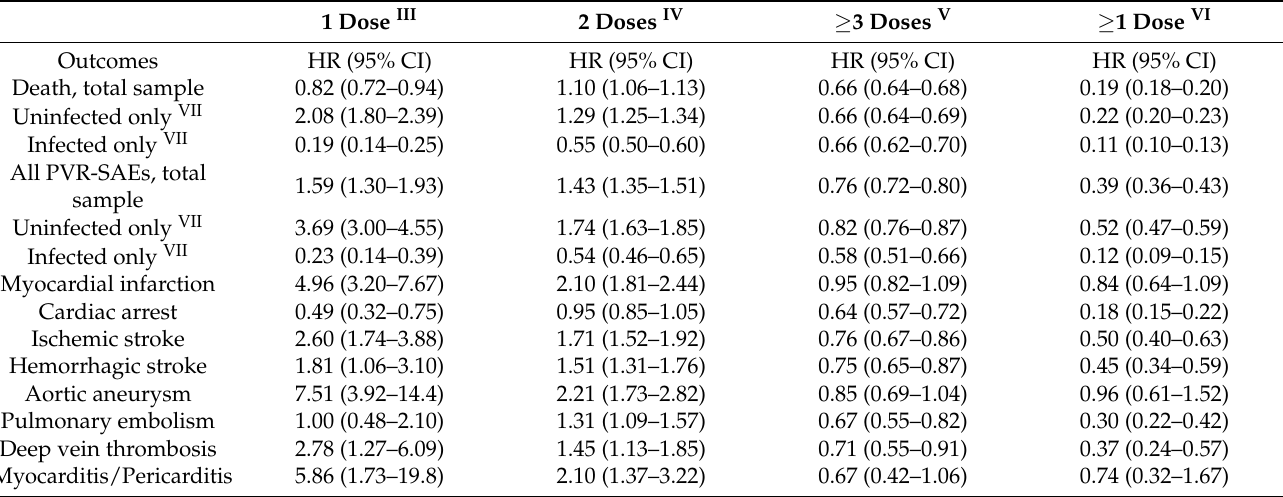
Table 3. Adjusted hazards ratios (95% confidence interval—CI) I of death and potentially vaccine- related serious adverse events (PVR-SAEs) II , overall and by infection status. The unvaccinated group is the reference category for all